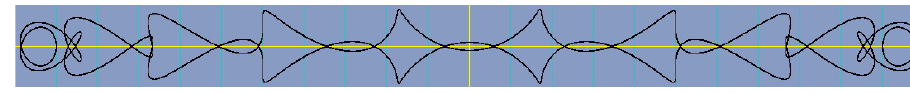
Figure 6. Epicycloid for values a = 500 and b =